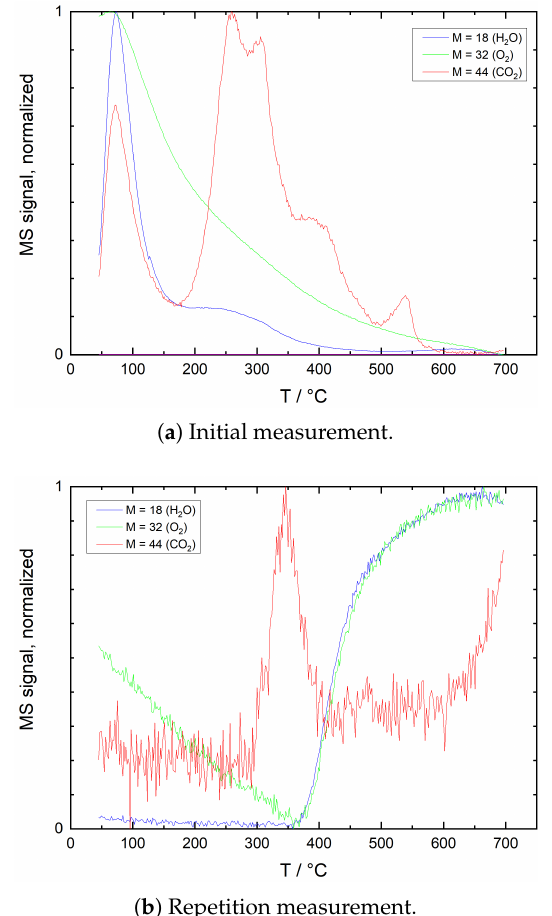
Figure 8. TPD plots of ITO powder in He+12.5vol% O 2 (He/O 2 ), showing normalized mass spectrometer signals for mass numbers 32 (O 2 ), 18 (H 2 O) and 44 (CO 2 ). ( a ) Initial measurement after 1h of powder exposure to ambient air at room temperature, ( b ) repetition measurement after cooling to room temperature following the initial measurement, without changing gas